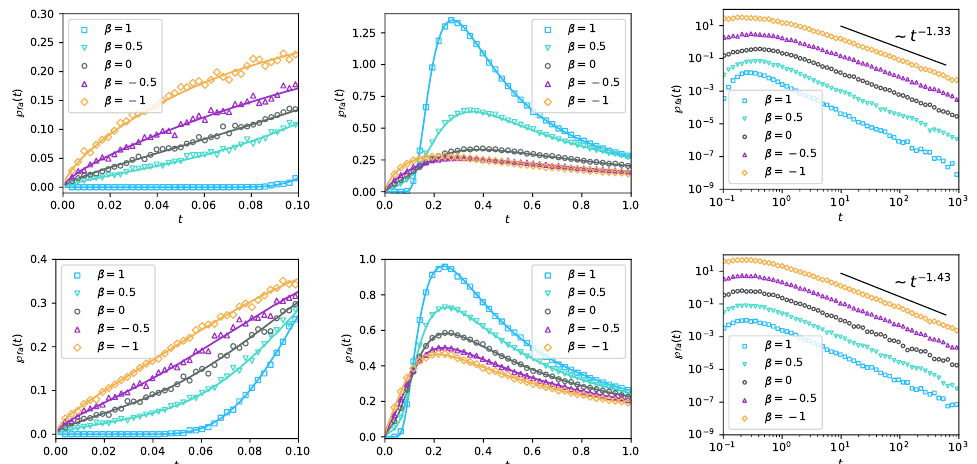
Figure 4. Left and centre: short-time behaviour for the first-arrival density of Lévy flights with different β , for α = 1.25, 1.5 and 1.75, from top to bottom, respectively. The solid lines are computed from the full expression (20). The coloured symbols depict the simulation results of the Langevin Equation (29). Right: same as the left panels but depicting the long-time behaviour. The short black line shows the asymptote t − 2 + 1/ α . Note that for better visual comparison the results are multiplied by a factor of 0.01 for β = 1, of 0.1 for β = 0.5, of 10 for β = − 0.5 and of 100 for β = − 1. We chose the time steps ∆ t = 0.00001 for the t → 0 limit in the left panels, ∆ t = 0.0001 to simulate the short-time behaviour in the middle panels and ∆ t = 0.001 for the long-time behaviour in the right panels, with N = 2 × 10 6 realisations. Moreover, K α = 1 and with x 0 = 1, and the target size was chosen as 2 ( D α ∆ t ) 1/ α . We note that for the case β = 1, a decrease of α means that the long-time asymptotic behaviour will be observed at longer times.